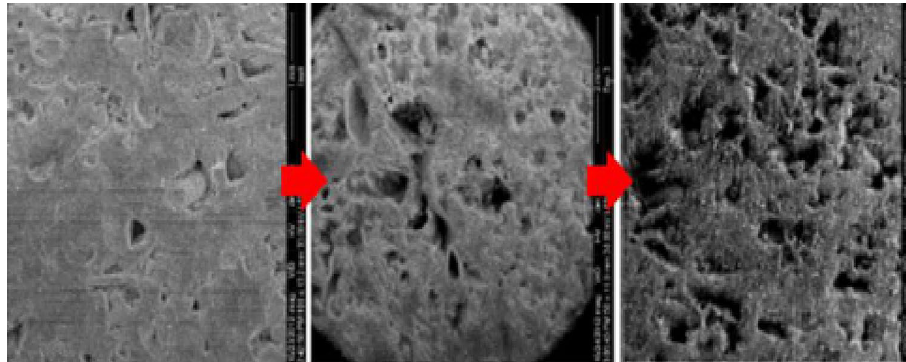
Fig. 6 Example of the dissolu- tion of minerals on reservoir rock over time, post CO 2 injec- tion for